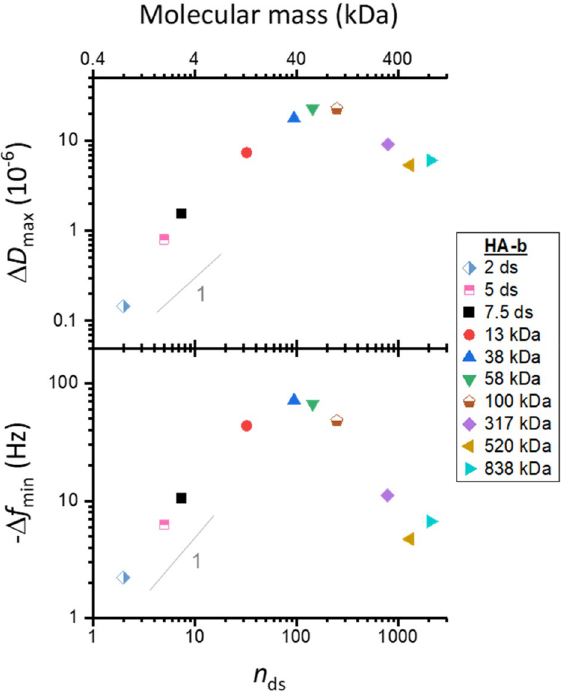
Figure 2. Maximal QCM-D responses vary non-monotonically with HA size. Double-logarithmic plots with shifts in dissipation (Δ D max ) and normalised frequency (− Δ f min ; i = 3) at maximum GAG binding as a function of the mean number of disaccharides, n ds , per chain. Estimated experimental uncertainties (accounting for baseline drift upon HA binding: 0.67 × 10 −6 for Δ D and 0.33 Hz for Δ f per hour) are smaller than the symbol size and not shown. Grey lines with a slope of one are shown for reference: − Δ f min increases roughly linearly with HA size for small HA sizes. Incubation conditions: HA-b oligosaccharides (2, 5 and 7.5 ds; all chains (cid:31) 3 kDa) and HA-b polysaccharides (13, 38, 58 and 317 kDa)—5 μg/mL; HA-b 100 kDa—10 µg/mL; HA-b 520 kDa and HA-b 838 kDa—20 μg/mL; see Fig. S2 for original